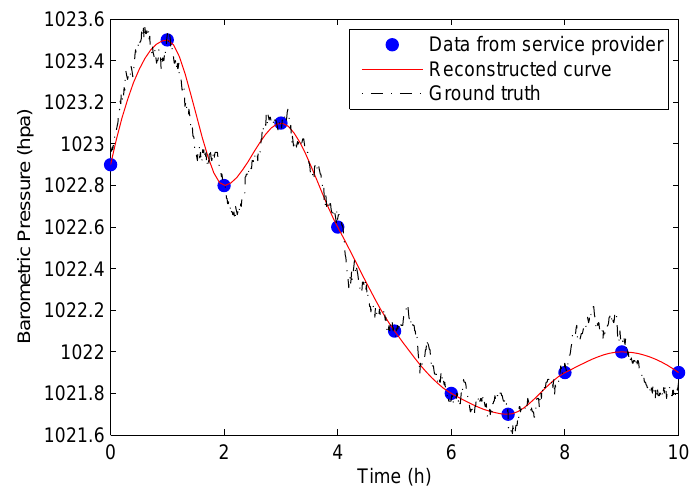
Figure 3. Reconstruct the curve of the barometric pressure.